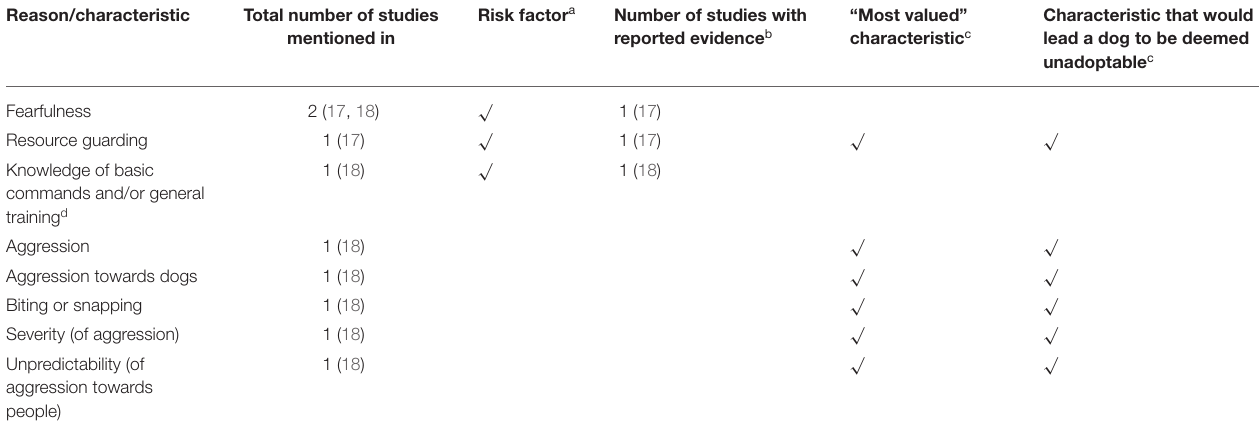
TABLE 5 | Dog assessment themes or sub-themes that are reported in the literature in owner-reported dog behavioural histories prior to biting incident. Reason/characteristic Total number of studies Risk factor a Number of studies with “Most valued” Characteristic that would mentioned in reported evidence b characteristic c lead a dog to be deemed unadoptable